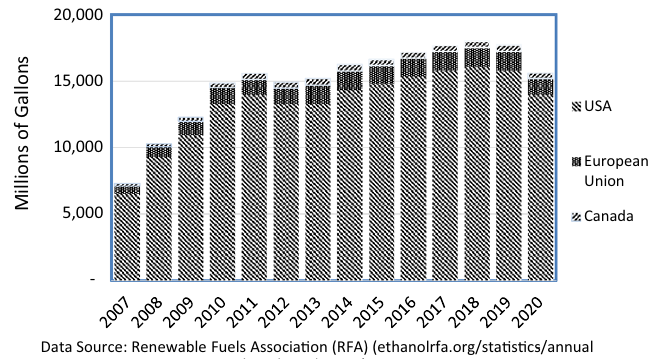
Fig. 1 Trends in ethanol production in Canada, USA, and the EU countries